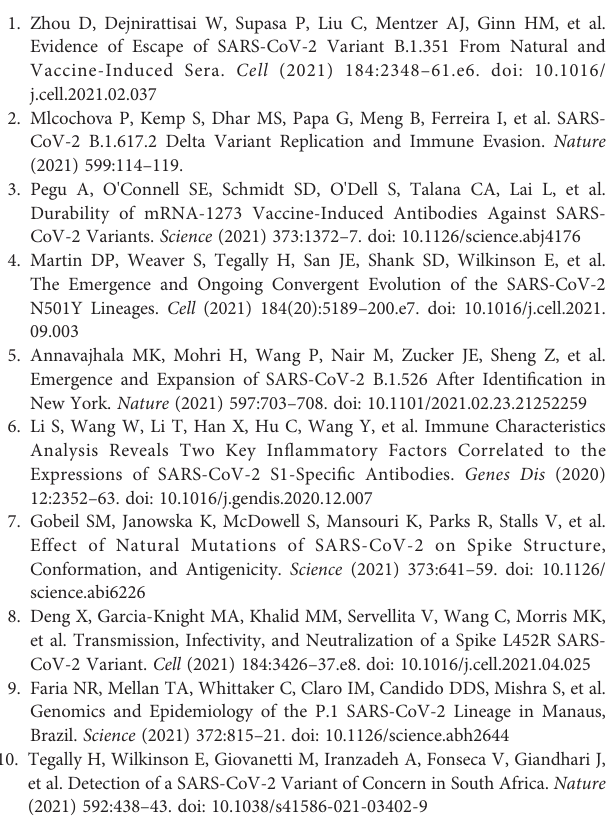
Supplementary Figure 6 | Related to Figure 4 . The expression of IFN- g gated on CD8 + T cells (A) and on CD4 + T cells (B) on the 10th day after the last immunization. Supplementary Figure7 | Related to Figure5 . (A) Stimulation withR848andIL- 2 for 6 days, the ELISPOT picture showed the number of RBD-speci fi c IgG spots per 5 × 10 5 splenocytes of each mouse. (B) The binding abilities of 10-fold serially diluted mouse serum to SARS-CoV-2 RBD recombinant protein. The ratio of Tn Supplementary Figure 8 | Related to Figure 6 . The expression of CD69 (A) and CD137 (B) (gated on CD8 + T cells of immune mice) were detected by fl ow Supplementary Table 1 | The information of Groups and OD 405nm were listed in Supplementary Table1 .And thethresholdfor groupingis1.788, inaccordance with the average OD value of 31 samples. Supplementary Table 2 | The clinical information and RBD-hACE2 interaction inhibition titers (IC 50 ) and SARS-CoV-2 pseudovirus neutralization titers (IC 50 ) were listed in Table 2 . Supplementary Table 3 | The information of immunized mice was listed in Table 3 . Supplementary Table 4 | The sequence information of SARS-COV-2 strains during RBD9.1 area were listed in Table 4